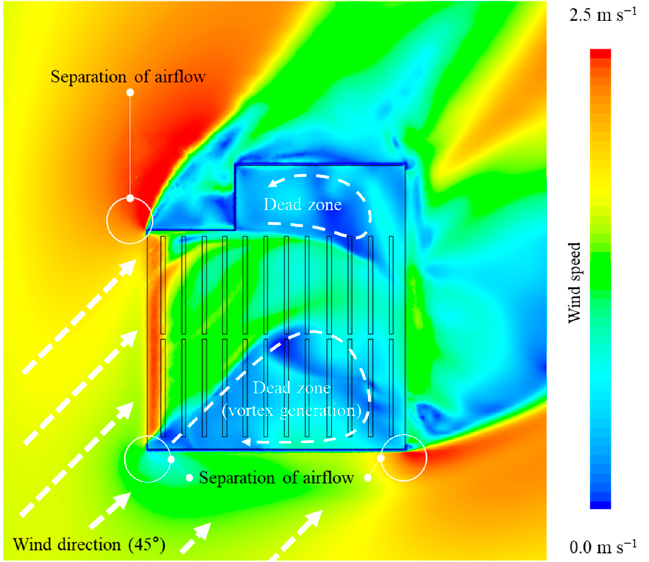
Figure 10. Airflow pattern inside and outside the greenhouse according to the WD of 45° (WS: 3.0 m s − 1 , and crop height: 1.0 m).